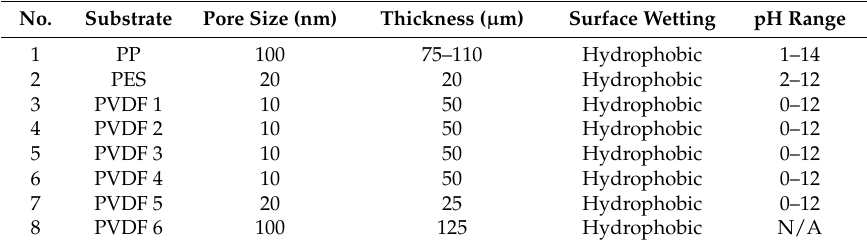
Table 1. Polymeric substrate characteristics. (PP: polypropylene; PES: polyethersulfone; PVDF: polyvinylidene difluoride).